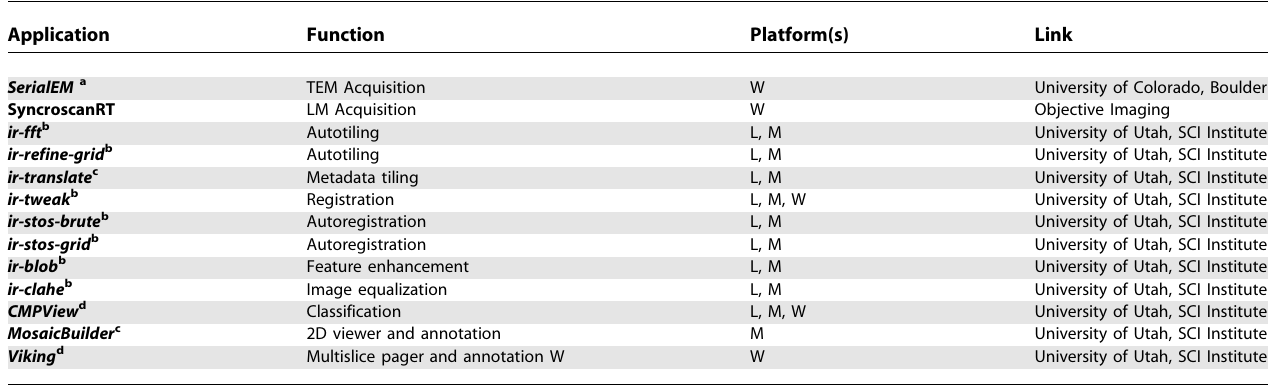
Table 1. Software Tools and